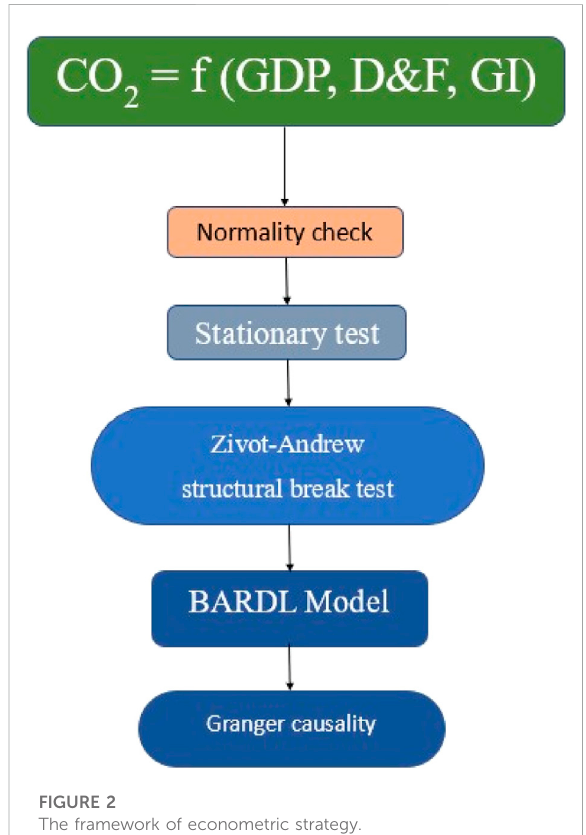
FIGURE 2 The framework of econometric